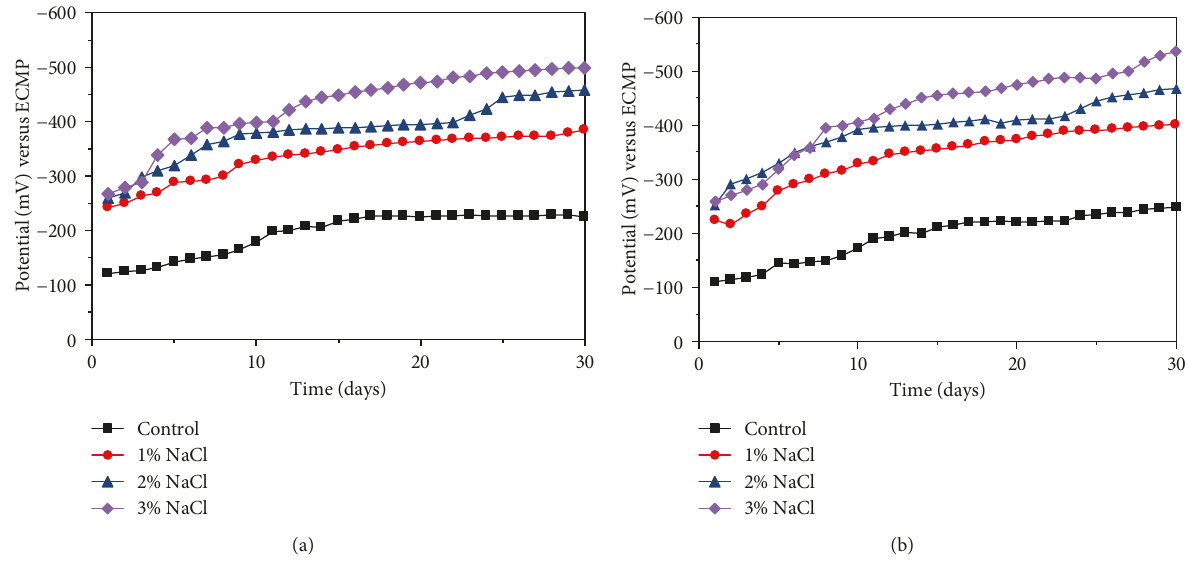
Figure 7: OCP curve for the rebar (a) and prestressed steel (b) in chloride-contaminated